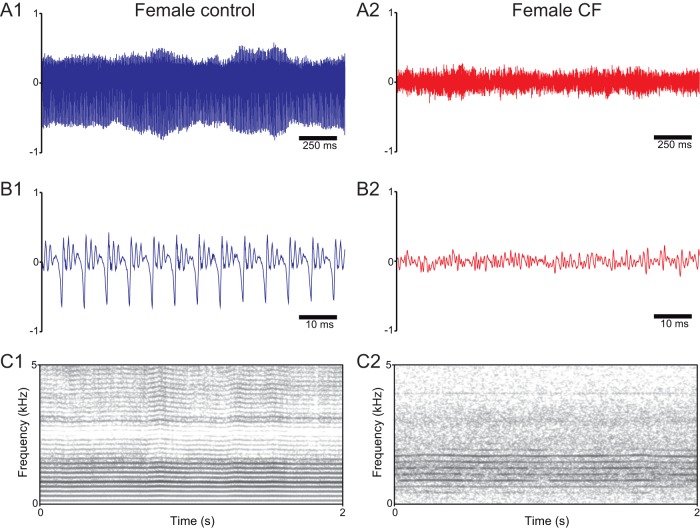
Representative voice recordings and spectrograms of female patients with CF (red) and healthy controls (blue).A: Sound recordings of/a/vowel phonations from a female control subject (A1) and a female patient with CF (A2); note the markedly reduced amplitude range of the signal from the CF patient in relation to the control. B: Amplified views of the recordings presented in A1 and A2; note the irregularity of the voice signal from the CF patient in relation to the control. C: Spectrogram (frequency domain) representations of the recordings presented in A1 and A2; note the higher level of background noise and low formant segregation in the CF patient in relation to the healthy control.